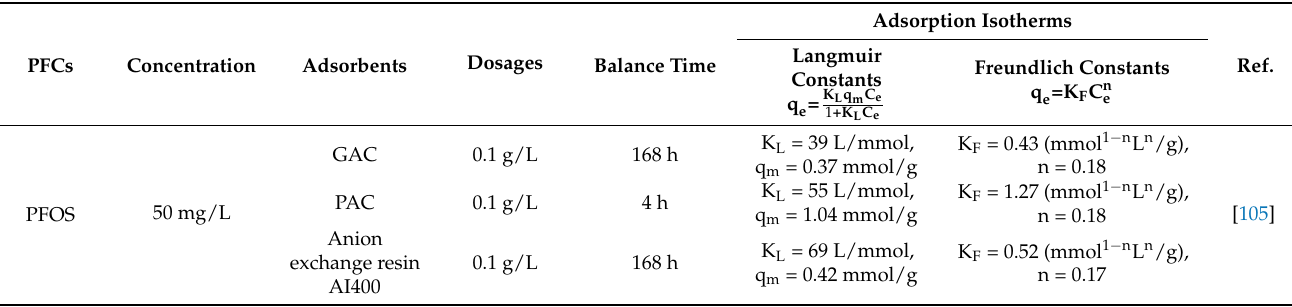
Table 2. Adsorption of PFCs by different